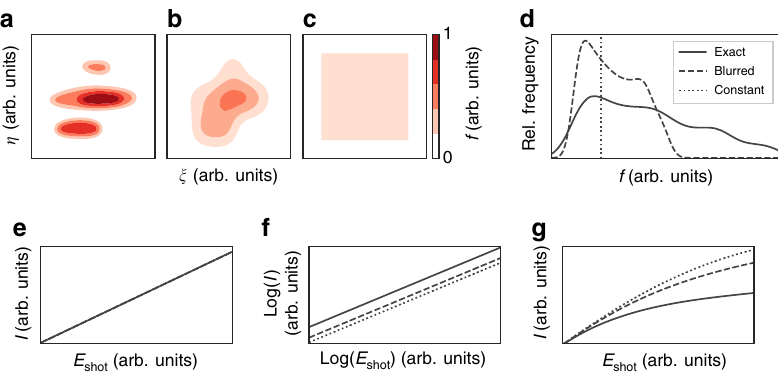
Fig. 1 Examples of spatial fl uence distribution estimates. Simulated two-dimensional maps of the spatial fl uence distribution in the sample plane ( f ( ξ , η ), representing a an exact measurement, b a blurred, low-resolution measurement, and c a constant estimate. All maps sum to the same overall shot energy E – c . e – g Simulated scattering signal I ( f ) for increasing overall shot energy in the three fl uence distributions shot . d Fluence histograms of the three maps in a under the assumption of, respectively, linear, quadratic, and saturating fl uence dependency. Note the double logarithmic scale in f